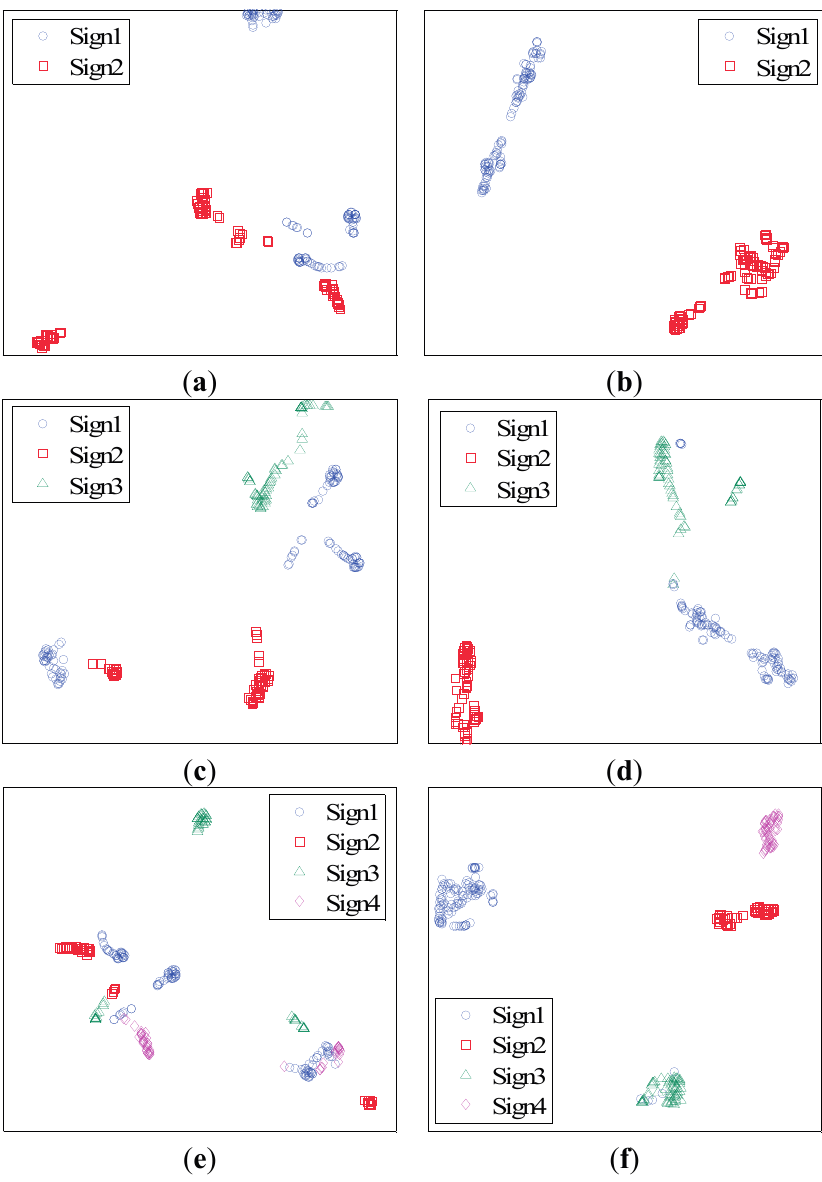
Figure 1. ( a ) t-SNE for two signs; ( b ) FSS-t-SNE for two signs; ( c ) t-SNE for three